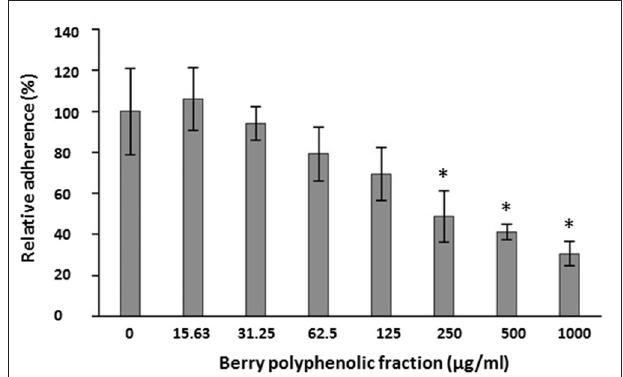
FIGURE 3 | Effect of the berry polyphenolic fraction on the adhesion of P. gingivalis to the Matrigel ® basement membrane model. A relative value of 100% was assigned to the adherence in the absence of the berry polyphenolic fraction. Results are expressed as the means ± SD of triplicate assays from three independent experiments. *Significant inhibition ( p < 0.01) compared to the control.